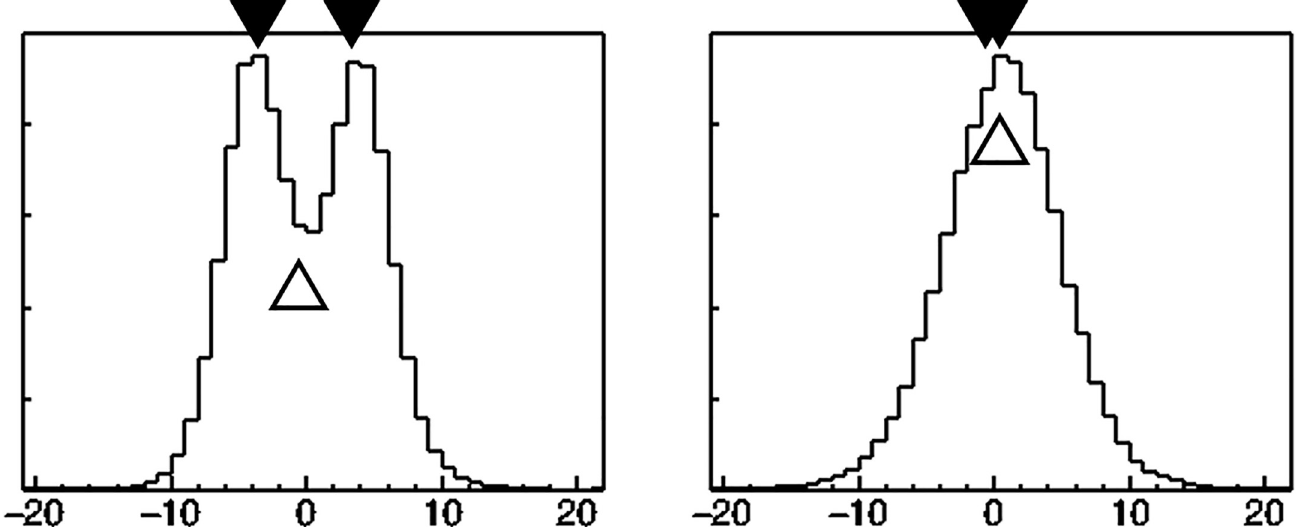
Fig 2. Examples of the line profile for spatial resolution analysis. The two point sources are said to be distinct when the maximum values in both x < 0 and x > 0 are larger than the value of x = 0 in the profile of y = 0 (the origin was defined as the centre of the images). (A): distinguishable, (B): indistinguishable.